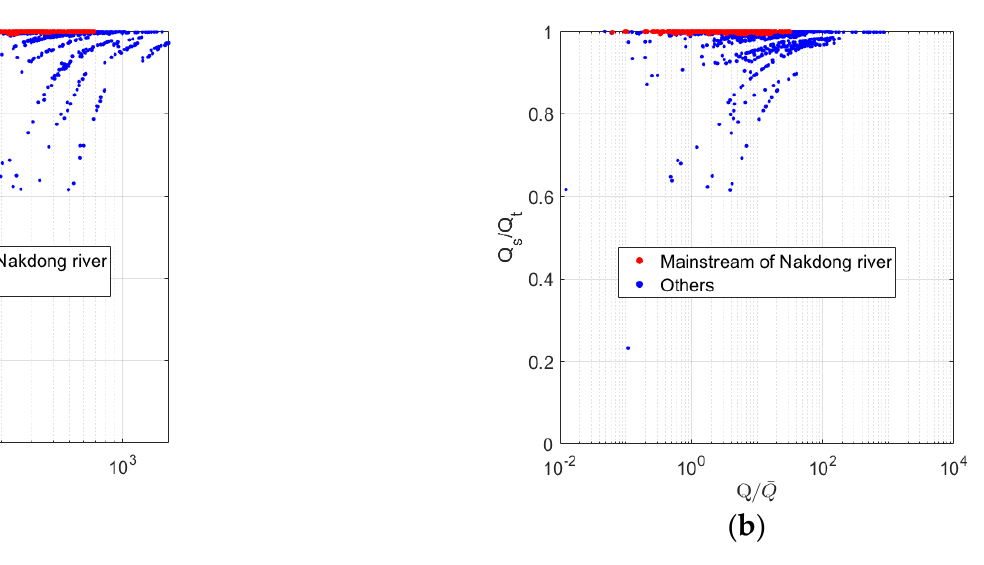
Figure 3. Relationship between the ratio of suspended sediment to total sediment load based on